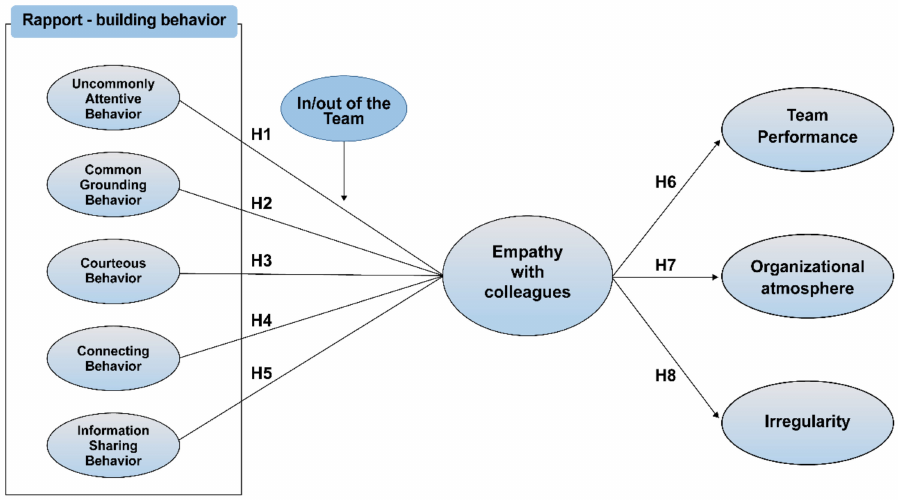
Figure 1. Conceptual